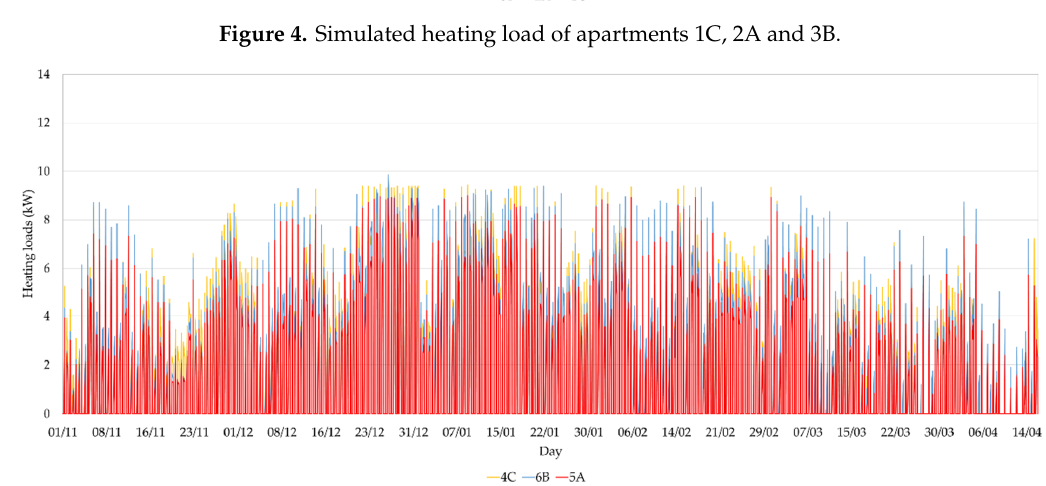
Appl. Sci. 2020 , 10 , x FOR PEER REVIEW Figure 5. Simulated heating load of apartments 4C, 5A and 6B. Figure 5. Simulated heating load of apartments 4C, 5A and 6B. Figure 5. Simulated heating load of apartments 4C, 5A and 6B.